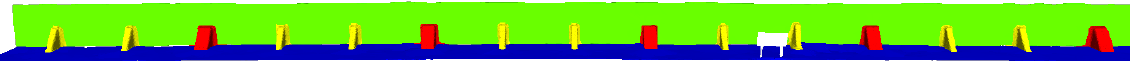
Figure 15. Results of arranging polygons into a point